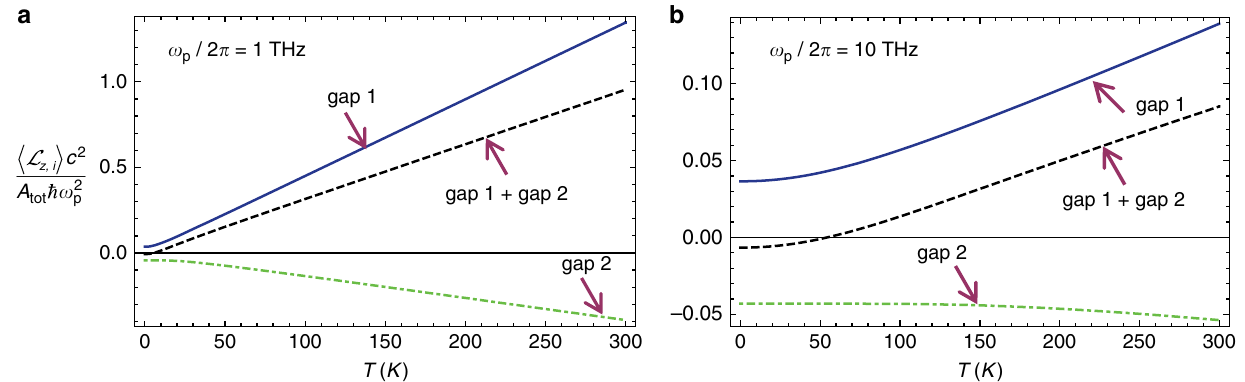
and the plasma frequency p ¼ 0 : 8 ω . Solid blue line: contribution from the 1st (low-frequency) band gap. c p